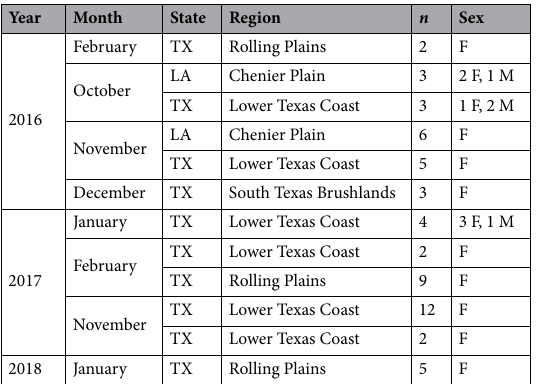
Table 1. Capture details for 56 greater white-fronted geese ( Anser albifrons frontalis ) including capture year, month, state, and region, individual sex, and tracking device information for geese captured during winters 2016–2017 and